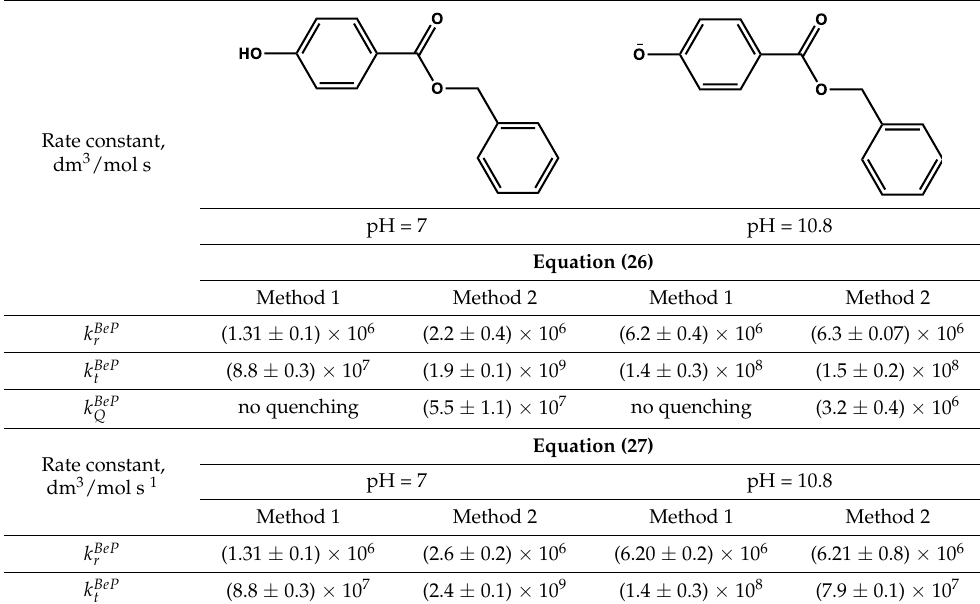
Table 4. Determined kinetic rate constant of BeP reaction with singlet oxygen and excited 3 TPPS 4 * with the application of Equation (26) and Equation (27) with two approaches.